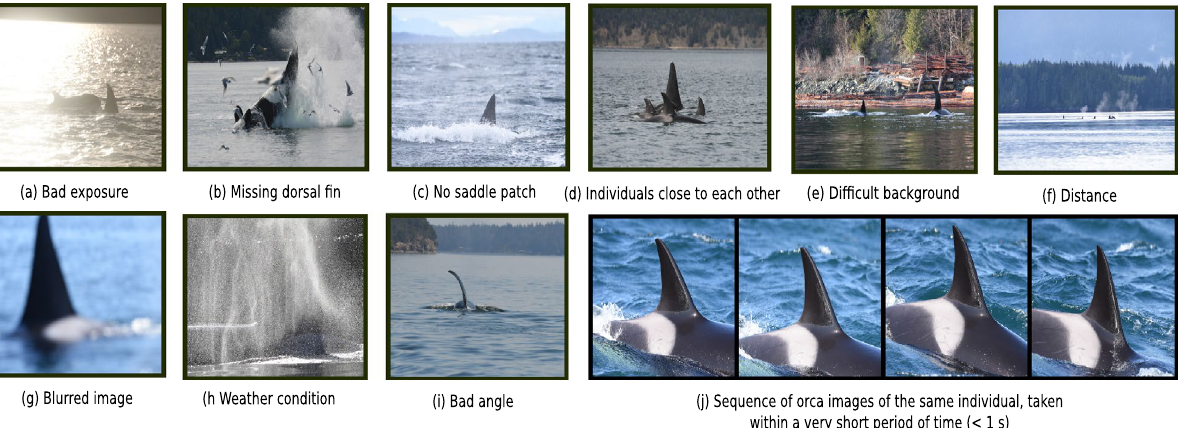
Figure 3. Examples of image content which either lead to completely unusable/invalid data samples, or which make a robust and correct detection/classification much more